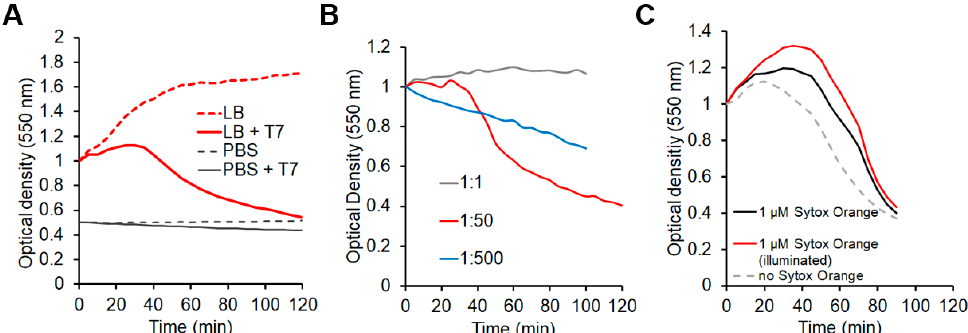
Figure 1. Bacterial growth kinetics: Optical density measurements corresponding to the density of the bacterial cultures over time. ( A ) Buffer composition influences bacterial growth. ( B ) Different MOIs have a significant impact on bacterial lysis. ( C ) Intercalator dyes delay and prolong infection-induced bacterial lysis. Optical density measurements were carried out in LB unless otherwise stated.